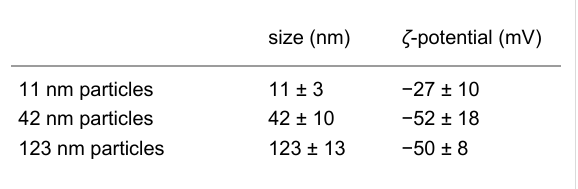
Table 2: Physical parameters for the used silica